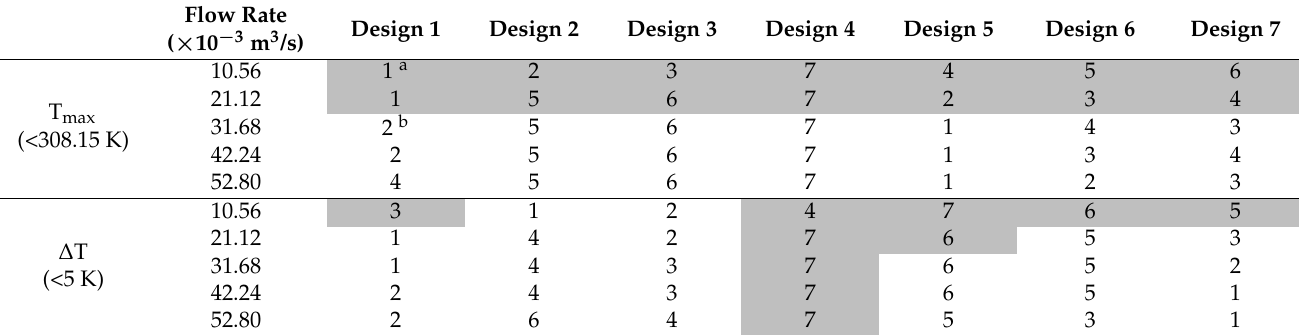
Table 5. A ranking and status of each design for two evaluation